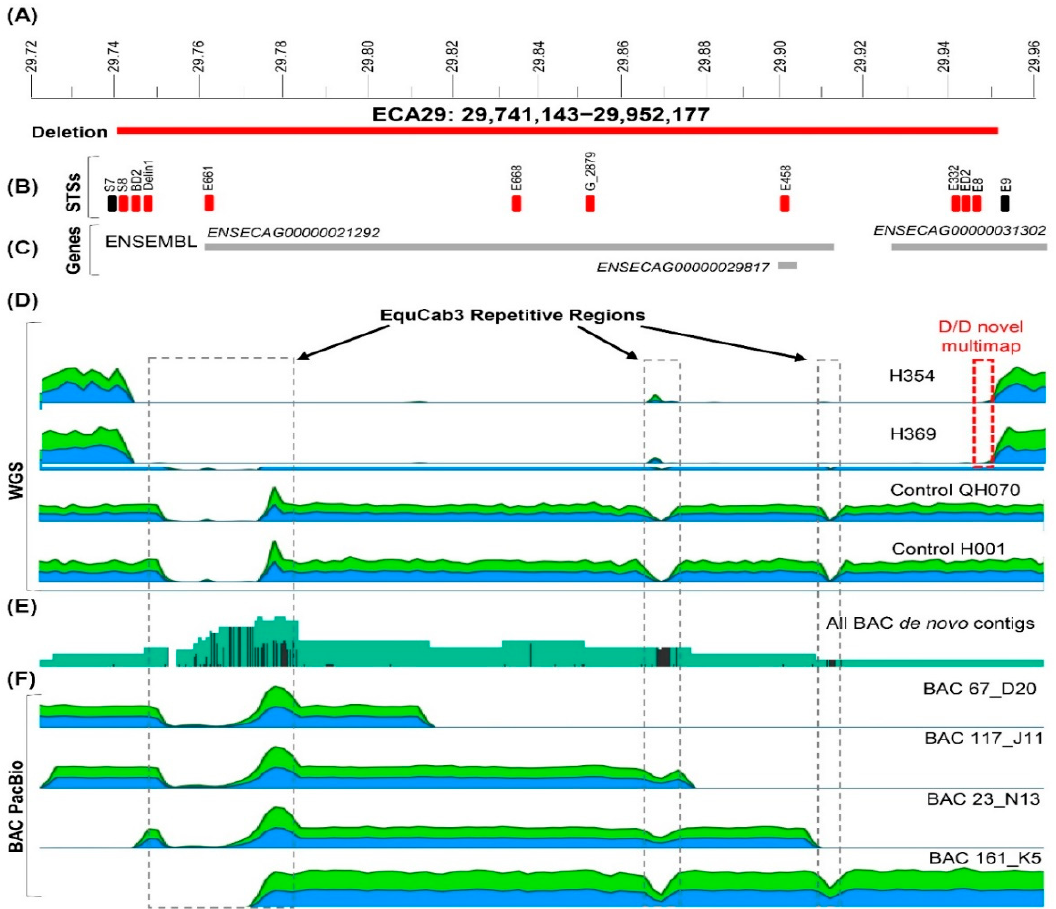
Figure 3. Schematic overview of the deleted region in ECA29: 29,741,143–29,952,177 (the approximate maximum span of the deletion based on whole genome sequence (WGS)). ( A ) Position of the deletion in ECA29 sequence map; (B) STSs in the region that were used for breakpoint analysis, detection of deletion homozygotes and to confirm homozygous deletion of specific genes; ( C ) Gene map of the region according to NCBI and Ensembl; ( D ) Relative read coverage plots for WGS of two cases and two control horses delineating the deleted region. Boxed in grey are known repetitive regions in EquCab3. Boxed in red is the structural variant present only with the documented deletion in cases, and ( E ) All de novo contigs assembled from BACs spanning the region of the deletion; ( F) Relative PacBio read coverage plots when aligned to EquCab3. In all sequence coverage plots, green color indicates plus-strand and blue color minus-strand alignment.